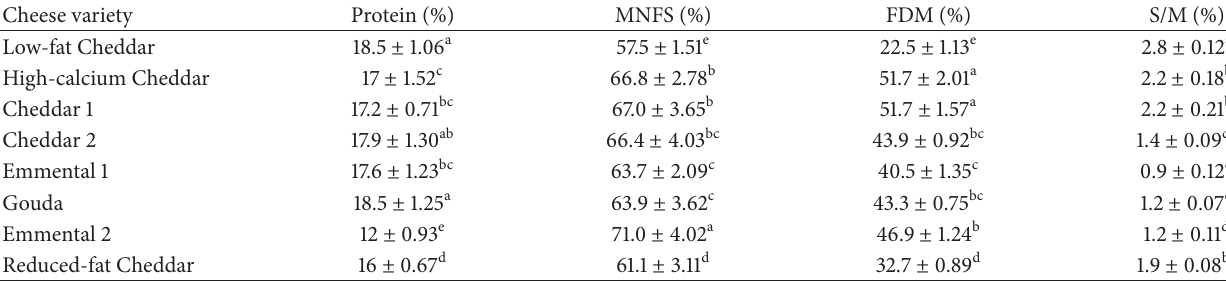
Table 1: Chemical compositions of eight varieties of sliced